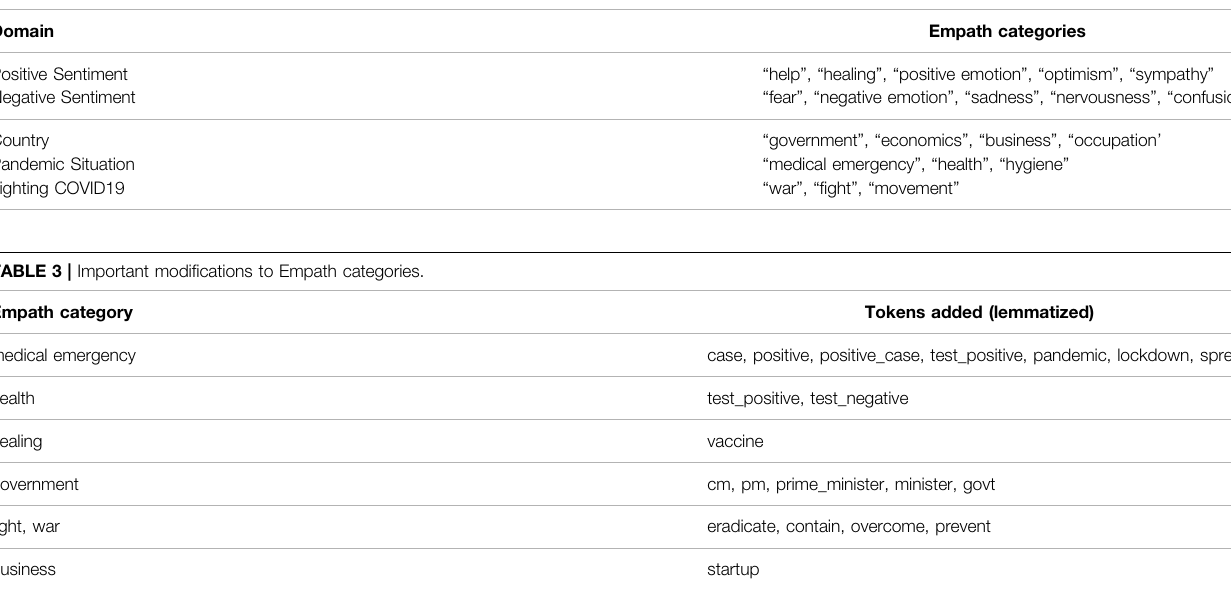
TABLE 2 | Empath Categories used for analysis.